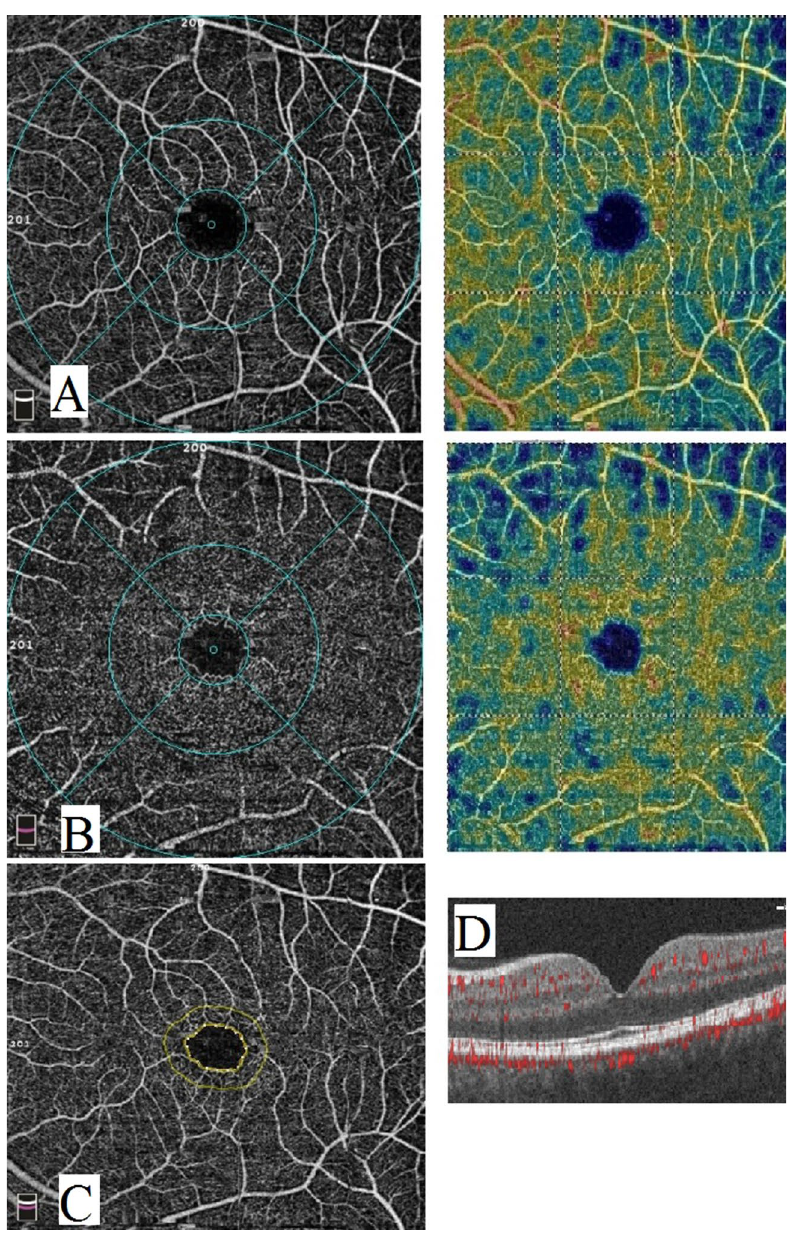
Figure 2. Optical coherence tomography angiography image of a psoriasis patient. ( A ) enface image at the level of SCP. ( B ) enface image at the level of DCP. ( C ) FAZ. ( D ) B scan image showing blood flow at the level of SCP, DCP and